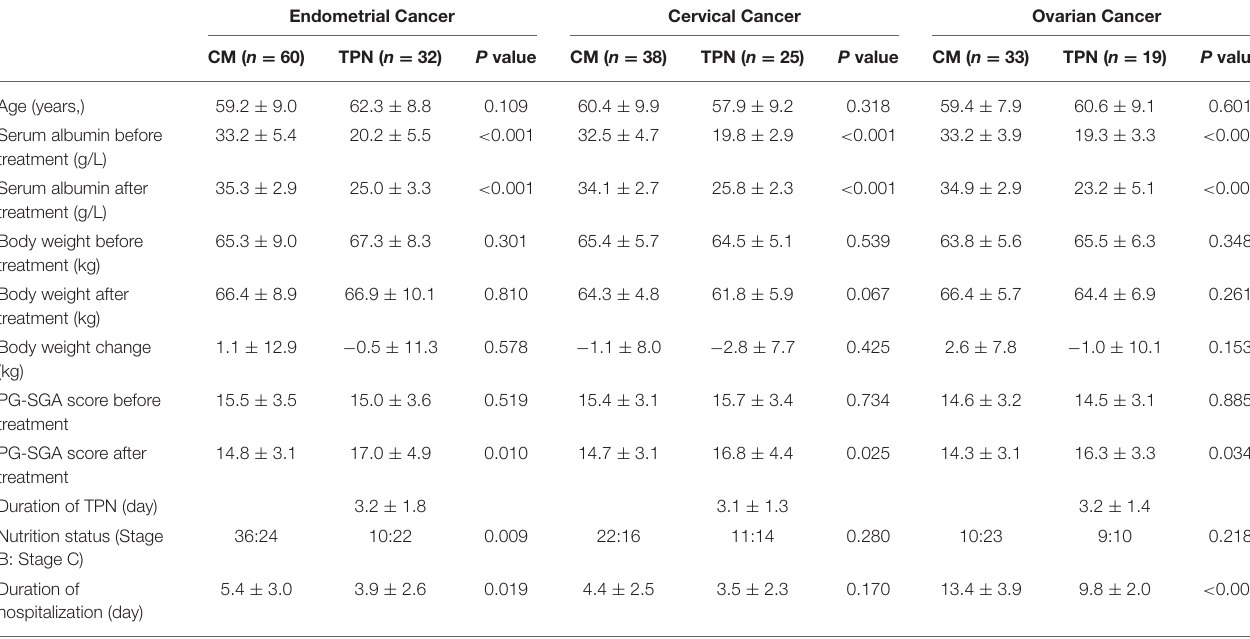
TABLE 4 | Characteristics of the patients treated with either TPN or conservative management.